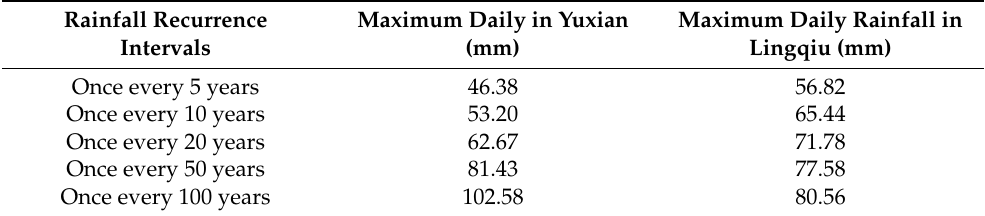
Table 3. Scenes of rainfall recurrence interval.